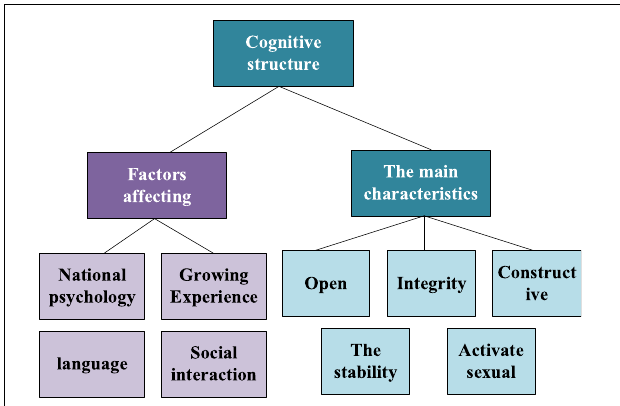
FIGURE 3 | Overview of cognitive